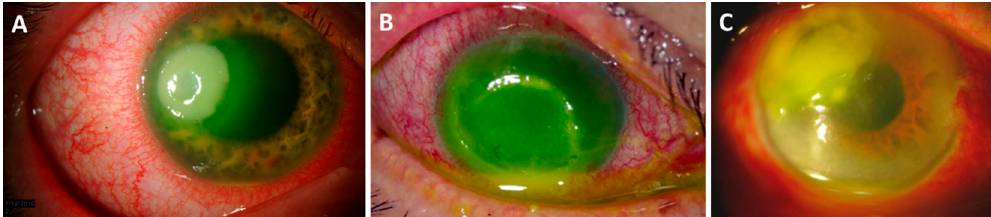
Figure 4. P. aeruginosa , MRSA, and S. pneumoniae keratitis. ( A ) A corneal ulcer caused by P. aeruginosa . PMN fill the ulcer, which may perforate the cornea. ( B ) A patient with MRSA keratitis after penetrating keratoplasty. This patient was treated with topical antibiotics and corticosteroids. ( C ) S.